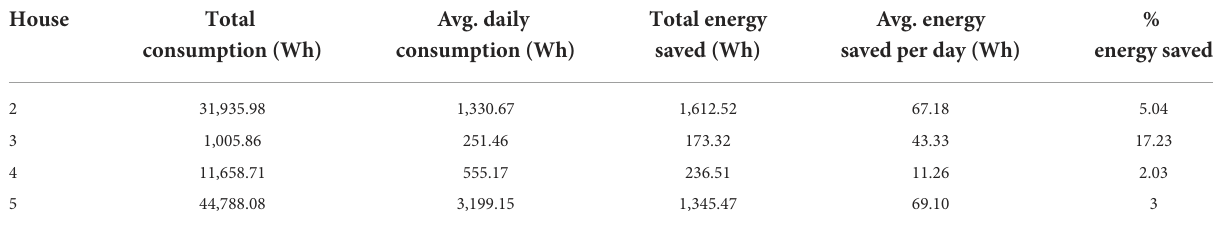
TABLE 8 UK-DALE energy saving statistics.